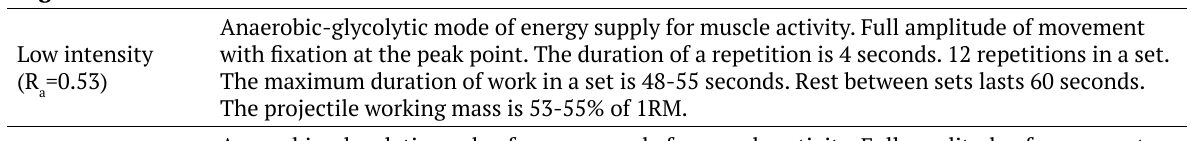
Table 1. Power load regimes used by MMA athletes in the process of strength training during the study Intensity of power